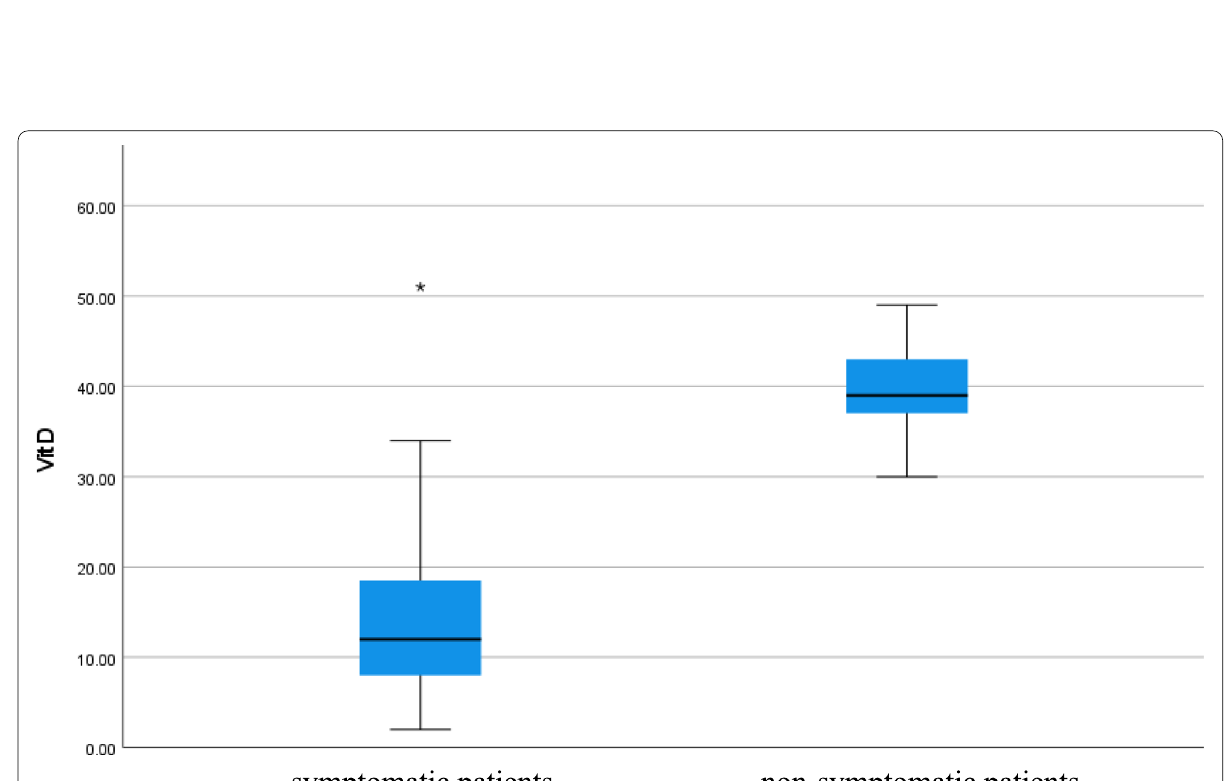
Fig. 8 Serum vitamin D level of COVID 19 patients (symptomatic and